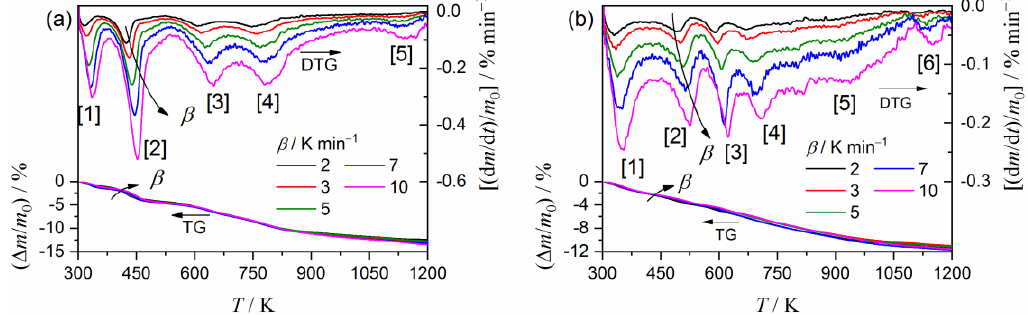
Figure 9. TG – DTG curves for the thermal decomposition of MB recorded at different β in a flow of air: ( a ) P-MB and ( b ) S-MB.